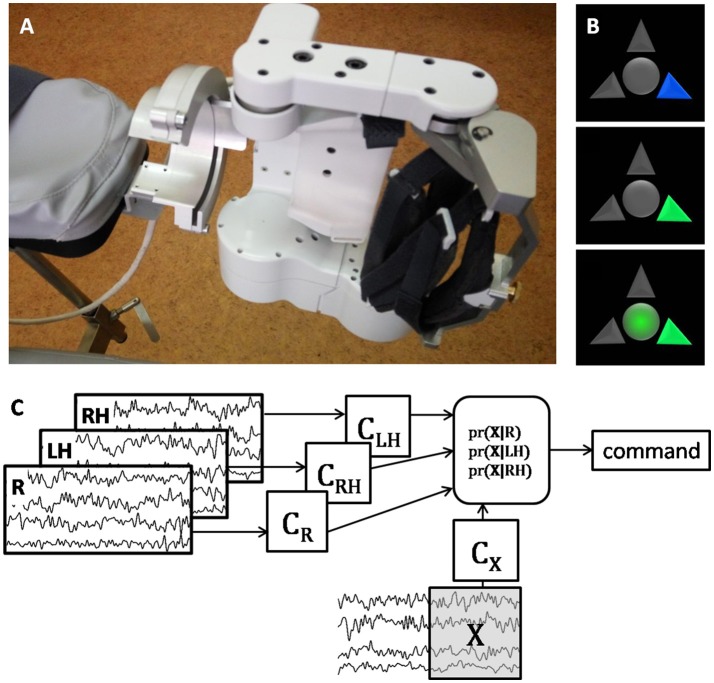
(A) photo of the left exoskeleton attached to the chair arm pad; the right exoskeleton has symmetrical construction. (B) visual cues of the BCI system; the upper arrow corresponds to relaxation, the left and right arrows correspond to the left and right hand extension imagery; the blue arrow signals the patient to prepare for performing the corresponding task; the green arrow signals the patient to start performing the task; circle in the middle of the screen serves both as a gaze fixation point and for additional visual feedback, it becomes green when the BCI classifier recognizes that the cued task is executed. (C) schematic illustration of the BCI classification algorithm. After several presentations of each task the corresponding EEG covariance matrices (CR for Relaxation, CLH and CRH for the left and hand motor imagery) are estimated. Then for each sliding 1 s EEG window, X, the probability of its corresponding to each task is estimated using the Bayesian approach. The command is generated based on the maximal probability, and the window is shifted as new EEG data are acquired. The more correct answers the BCI provides, the more is the exoskeleton extended.